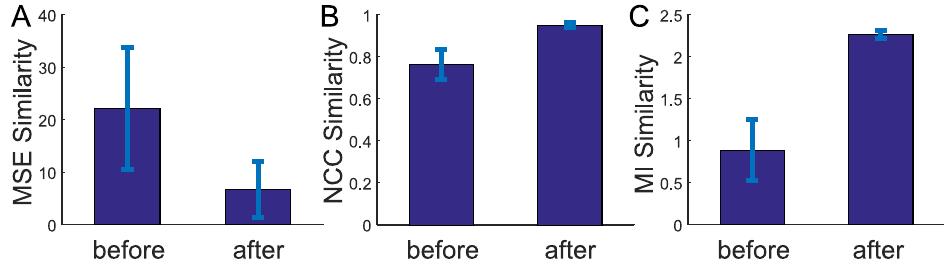
Fig 11. Comparison of intensity similarity measurement of the three metrics before and after registration. The mean and standard deviation of registration accuracy are calculated through mean square error (A), normalized cross correlation (B) and mutual information score (C). The registration accuracy is significantly improved after applying M3VR